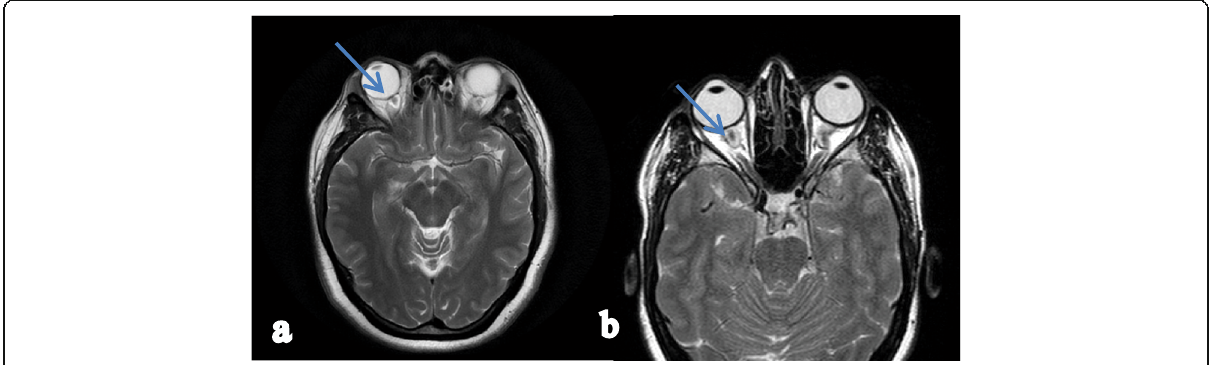
Fig. 4 MRI brain T2 sequence of a 25-year-old lady showing ( a ) intraocular protrusion of optic nerves and ( b ) optic hydrops